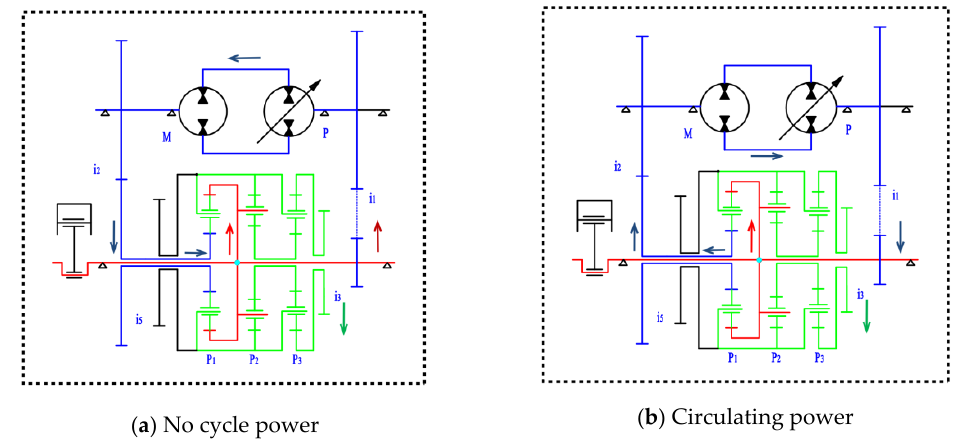
Figure 8. Power flow characteristic diagram of HM1 section.